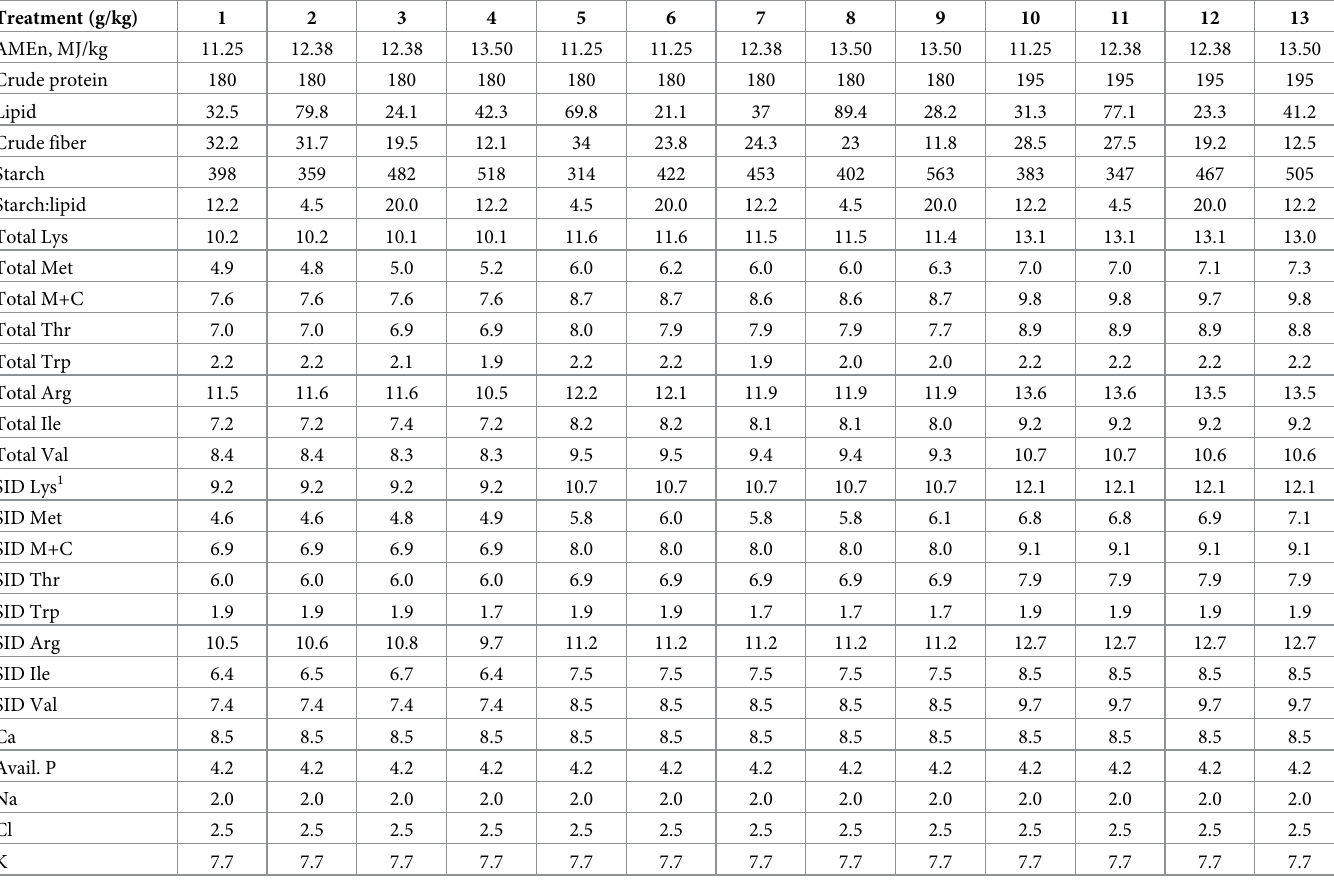
Table 4. Calculated nutrient specifications in experimental diets for broiler chickens from 21–35 days post-hatch. Treatment